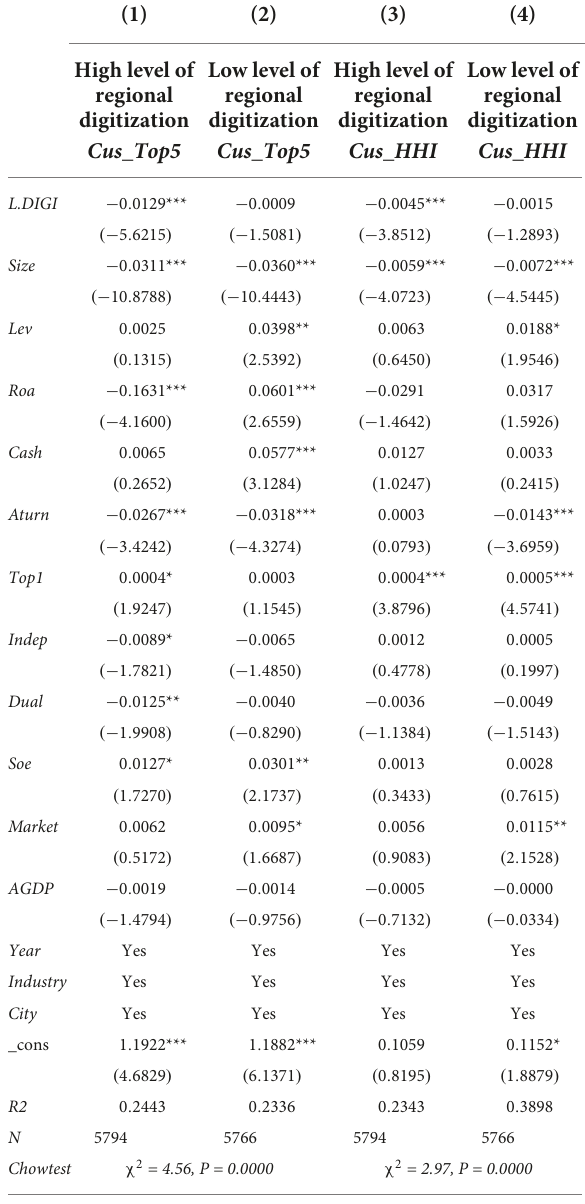
TABLE 8 Heterogeneity test of regional digitalization